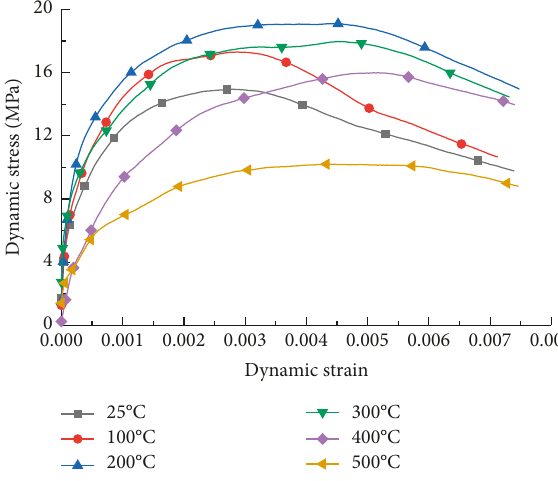
Figure 9: Dynamic splitting stress-strain curves of intact sandstone